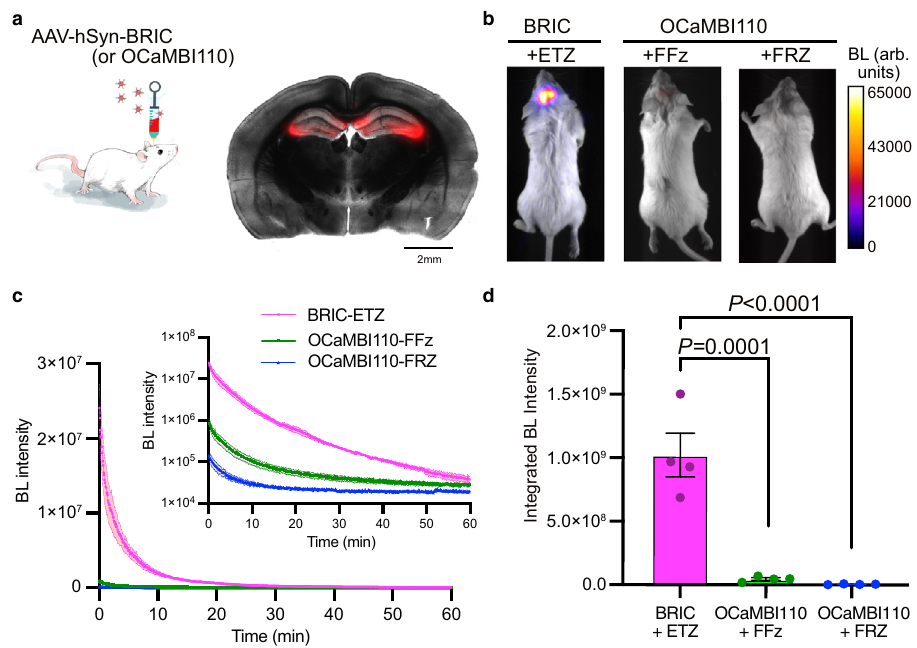
Fig. 3 Brightness comparison of BRIC and Orange CaMBI 110 (OCaMBI110) in the hippocampus in live mice. a Left: Illustration of stereotactic intracranial administration of AAVs. Right: Image of an acute brain slice prepared from a BRIC-transduced mouse, showing the successful expression of the indicator in the hippocampus. The fl uorescence channel (red) is overlaid on the corresponding grayscale bright fi eld image. Scale bar, 2 mm. b Representative bioluminescence images of live mice with the hippocampus transduced with BRIC or OCaMBI110 AAVs. The substrates were administered via tail vein at their respective saturation concentrations. Images with peak bioluminescence intensities were presented in pseudocolor overlaid on corresponding bright fi eld images. c Bioluminescence intensity over time presented for each substrate. The inset shows the same results with a logarithmic y-axis. d Comparison of the integrated bioluminescence intensity (area under the curve) with the residual background subtracted. Data are presented as mean ± s.e.m. ( n = 4 mice). P values were derived from ordinary one-way ANOVA followed by Dunnett ’ s multiple comparisons test. The GraphPad Prism software does not provide extract P values below 0.0001. BL, bioluminescence. Arb. units, arbitrary units. Source data are provided as a Source Data fi